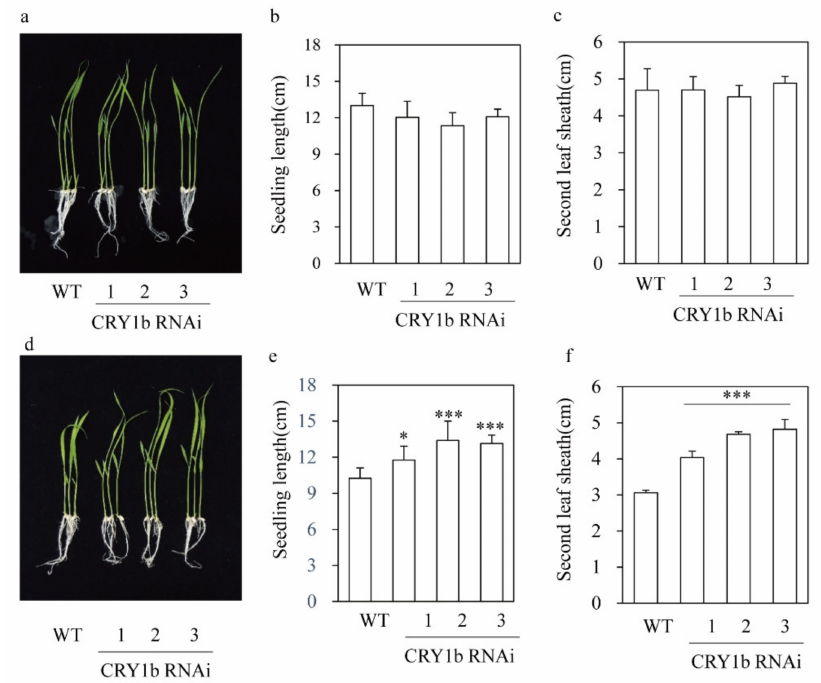
Figure 2. Seedling phenotypes of wild-type (WT) and CRY1b RNAi transgenic rice. ( a ) Representative seedling phenotypes, ( b ) shoot lengths, and ( c ) second leaf sheath lengths of plants grown under cool fluorescent light. ( d ) Representative seedling phenotypes, ( e ) shoot lengths, and ( f ) second leaf sheath lengths of plants grown under blue light. Rice seeds were germinated in half-strength MS medium and grown for 8 days at 28 ◦ C under a 14-h light/10-h dark cycle. Asterisks denote significant differences (* p < 0.05, *** p < 0.001) as determined by Tukey’s HSD post-hoc tests. Lines 1–3 are RNAi rice plants with downregulated CRY1b